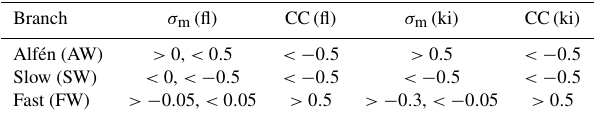
Table 1. Table of the thresholds used to identify different wave modes for fluid (fl) and kinetic (ki)